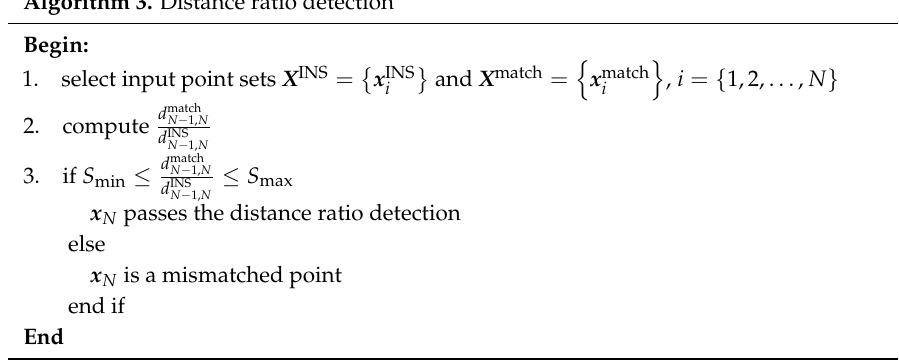
Algorithm 3. Distance ratio detection